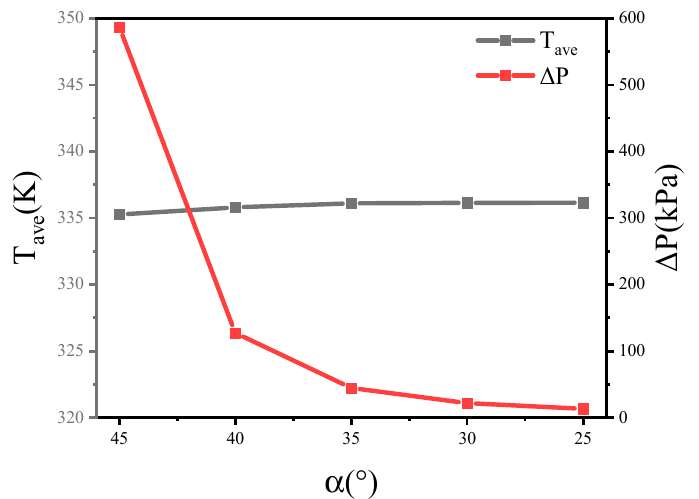
Figure 11. The average temperature and pressure drop of the heat source in different inclination angles of the cross-ribs.